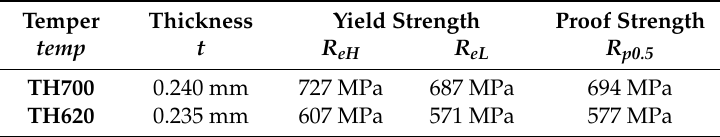
Table 2. Investigated high-strength packaging steels (HSPS)